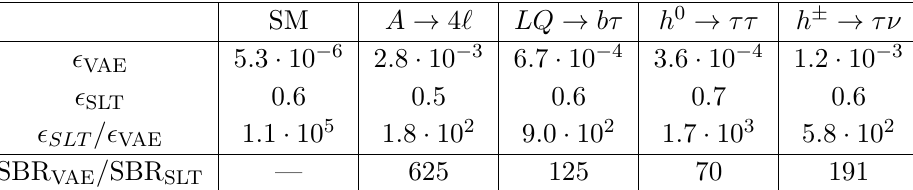
Table 5 . Selection e(cid:14)ciencies for a typical single lepton trigger (SLT) and the proposed VAE selection, shown for the four benchmark BSM models and for the SM cocktail. The last row quotes the corresponding BSM-to-SM ratio of signal-over-background ratios (SBRs), quantifying the purity of the selected